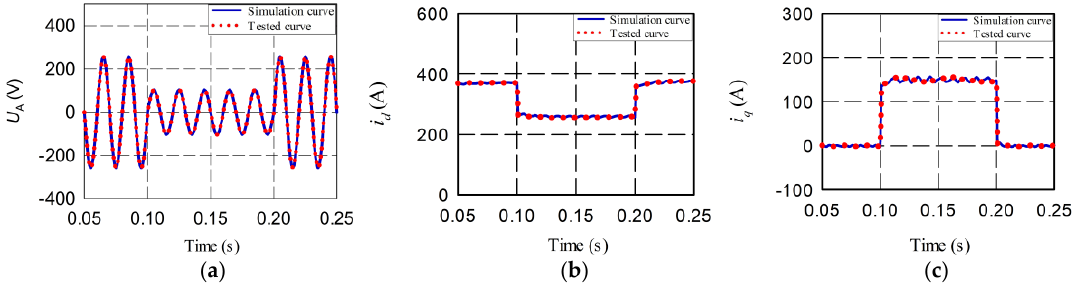
Figure 15. Comparison between simulation and tested curves under phase A voltage sag: ( a ) Simulation and tested curves of phase A; ( b ) Simulation and tested curves of d axis current; ( c ) Simulation and tested curves of q axis current.